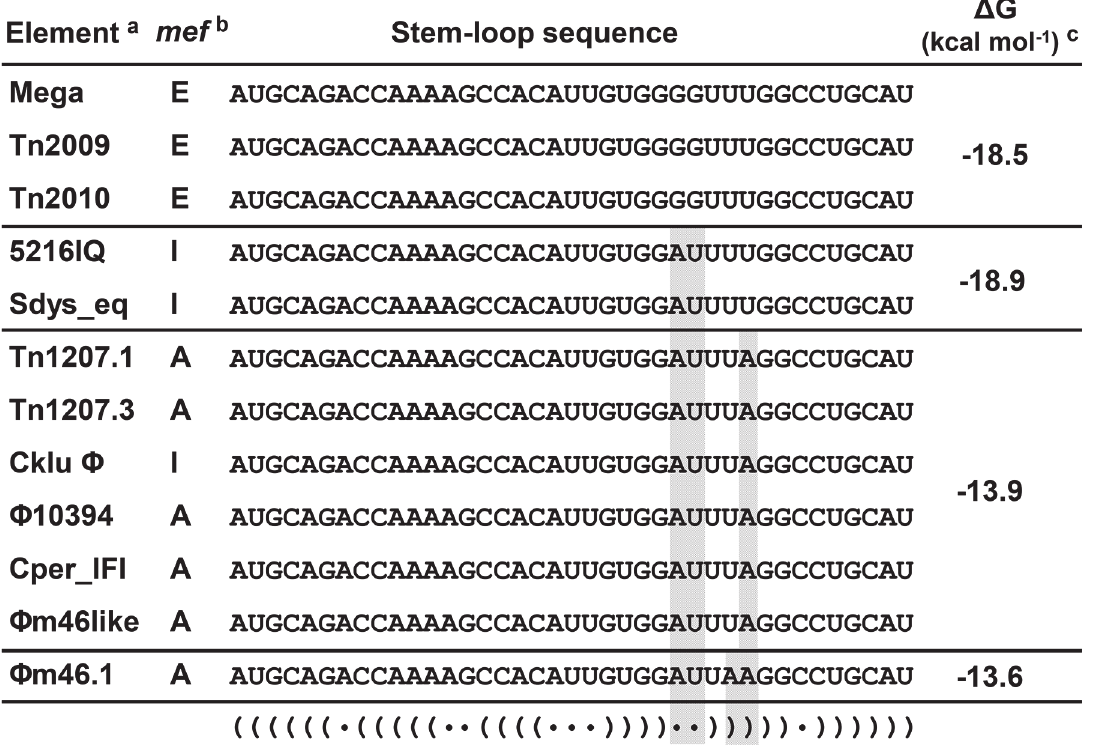
Fig 8. Comparison of the Rho-independent terminator in the Mega element in S . pneumonia e with predicted terminators from mobile elements found in other Gram-positive bacteria species. The nucleotide sequence of the stem-loop portion (not including the poly-uracil tract) of the predicted Rho- independent transcriptional terminators are aligned and single nucleotide polymorphisms are shaded gray. The predicted free energy ( Δ G) for each terminator is indicated The Rho-independent terminator structure from the Mega element is shown below in dot-bracket notation. Abbr., Mega (macrolide efflux genetic assembly), S . pneumoniae GA17457; Tn 2009, S . pneumoniae GA08825 Tn 916- like element (Genbank accession no. AILK01000006); Tn 2010, S . pneumoniae GA47628 Tn 916-like element (accession no. AILC01000010); 5612IQ, S . pneumoniae 5612IQ complex (accession no. AJ971089); Sdys_eq , S . dysgalactiae subspecies equisimilis G51 mef(A) element (accession no. AM168138); Tn 1207.1, S . pneumoniae England 14 – 1 phage-related element (accession no. AILI01000002); Tn 1207.3, S . pyogenes 2812A phage-related element (accession no. AY657002); Cklu Φ , Clostridium kluyveri DSM 555 phage-related element (accession no. CP000673); Φ MGAS10394, S . pyogenes MGAS10394 phage-related element (access no. CP000003); Cper_IFI, C . perfringens IFI mef(A) element (access no. EU553549); S . pyogenes MB56Spyo045 Φ m46.1-like (access no. JF501521); Φ M46.1, S . pyogenes Φ m46.1 (access no.